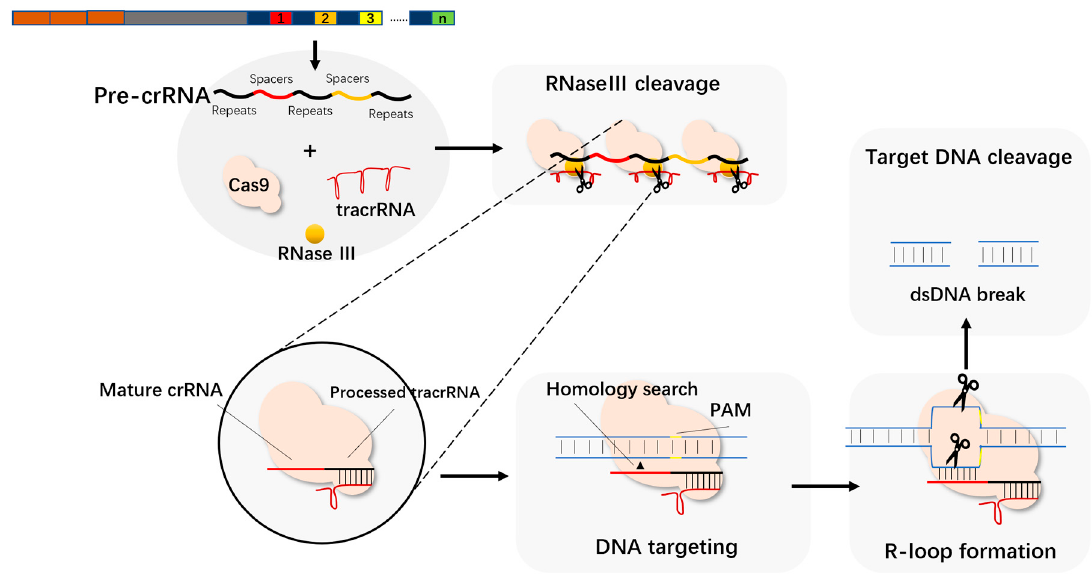
Figure 3. TracrRNA and mature crRNA form a dimer to guide the cleavage of the target sequence.